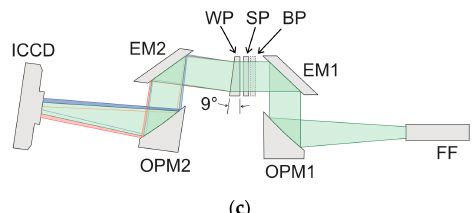
Figure 1. ( a ) Schematic illustration of the tomographic setup. The emission of the flame is imaged by ten 45° deflection mirrors and suitable telescopes onto individual rows of optical fibers. See reference [41] for more details. ( b ) 3D-representation of the tomographic setup and measurement test section. ( c ) Optical layout of the relay optic between the fiber output and the ICCD camera. The signal of each individual optical fiber is spatially separated into its wavelengths by a prism and imaged onto the camera. (FF: fiber ferrule, OPM: off-axis parabolic mirror, EM: flat-elliptical mirror, BP: band-pass filter (optional), SP: short-pass filter, WP: wedged prism.) Towards the camera, the optical fibers are brought together in a single ferrule in which the individual fiber rows of the different telescopes are stacked one above the other, each separated by a stainless-steel spacer. The output signal of the optical fibers is collimated by an off-axis parabolic mirror (OPM1) and deflected by a flat elliptical mirror (EM1) through a short-pass filter (SP) and a wedged prism (WP), as displayed in Figure 1c. The signal of each individual optical fiber is spatially separated into its wavelengths by the prism and imaged through another set of mirrors (EM2 & OPM2) onto the image-intensified CCD camera (ICCD). The short-pass (SP) filter prevents crosstalk of the spectrally separated signals from neighboring rows of optical fibers. Optionally, a band-pass filter (BP) can be used to limit the detection wavelength to a specific species, e.g., OH* @ 308 nm or